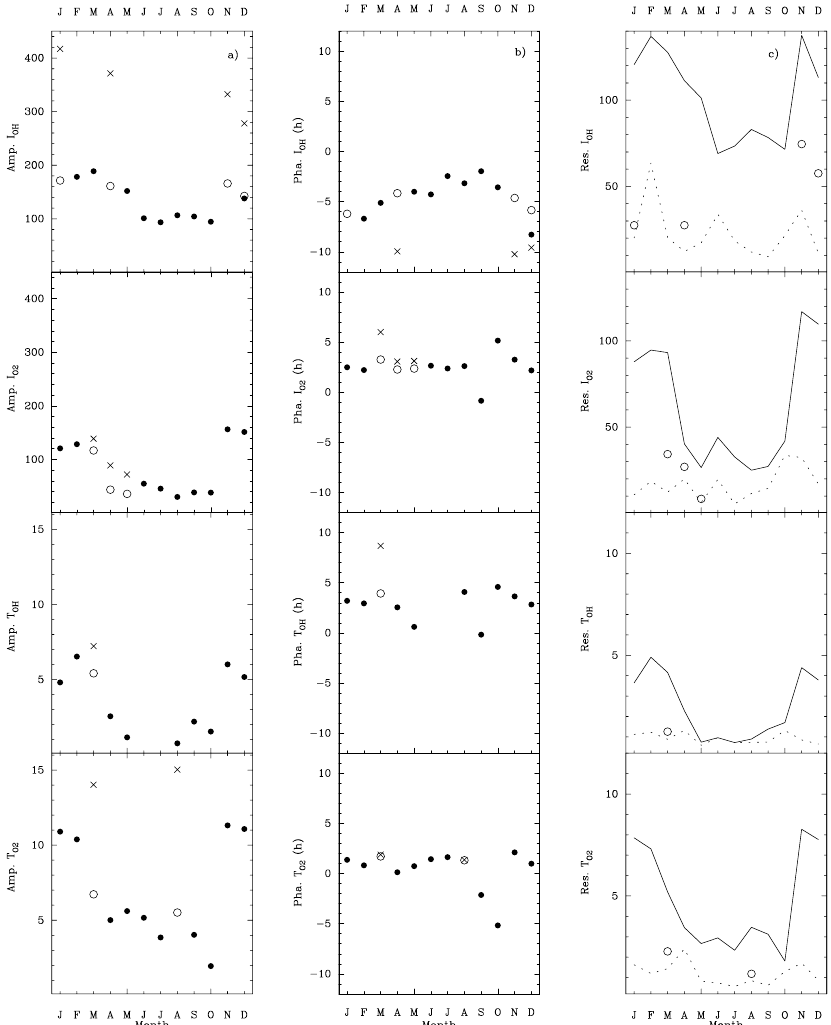
Fig. 2. (a) Relative amplitudes observed. (b) Phase of maxima. Crosses: diurnal tide. Black circles: semidiurnal tide. White circles: less probable semidiurnal fitting. (c) Residuals. Solid line: before fitting. Dashed line: after the fitting. White circles: after the fitting with a less probable semidiurnal